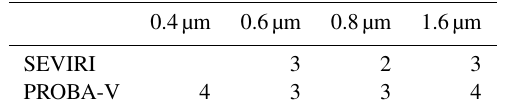
Table 3. Total radiometric uncertainty median values